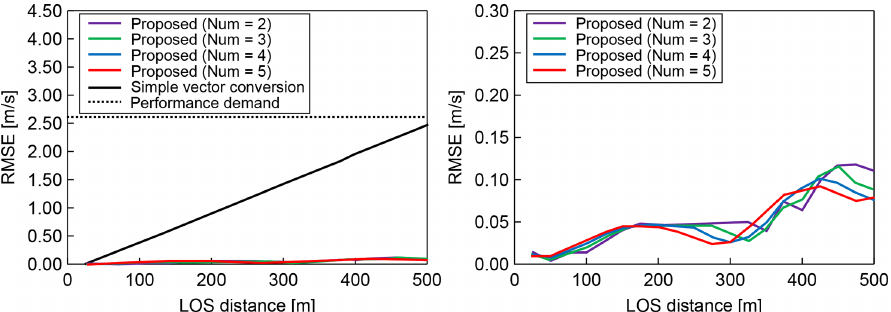
Figure 16. Statistical estimation performance (root mean square error) for numerical weather prediction results. Num is the number of past LOS wind values used.